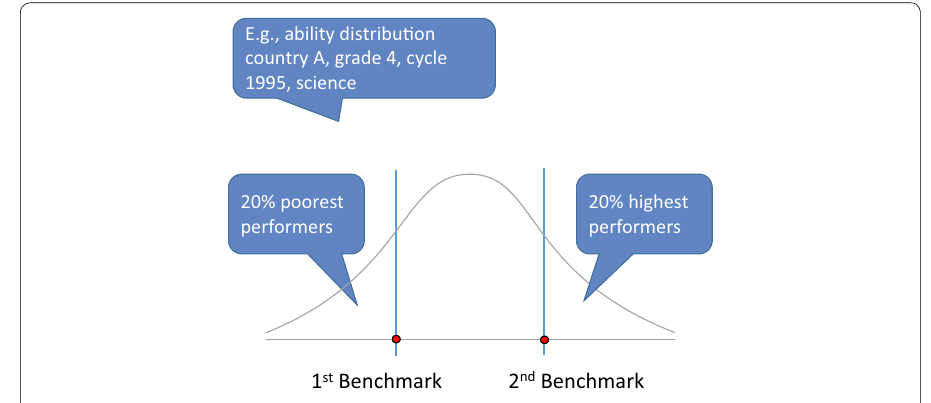
Fig. 1 Identifying the tails of the achievement